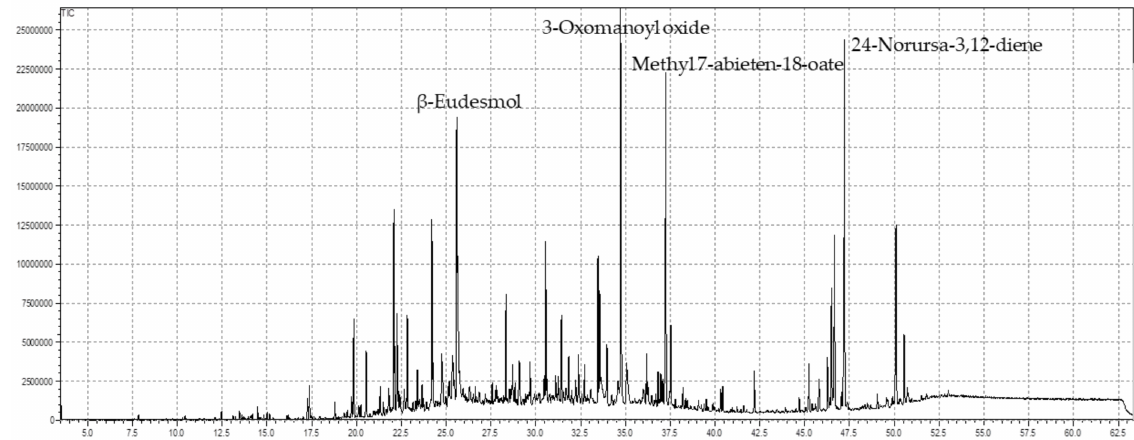
Figure 1. GC chromatogram of